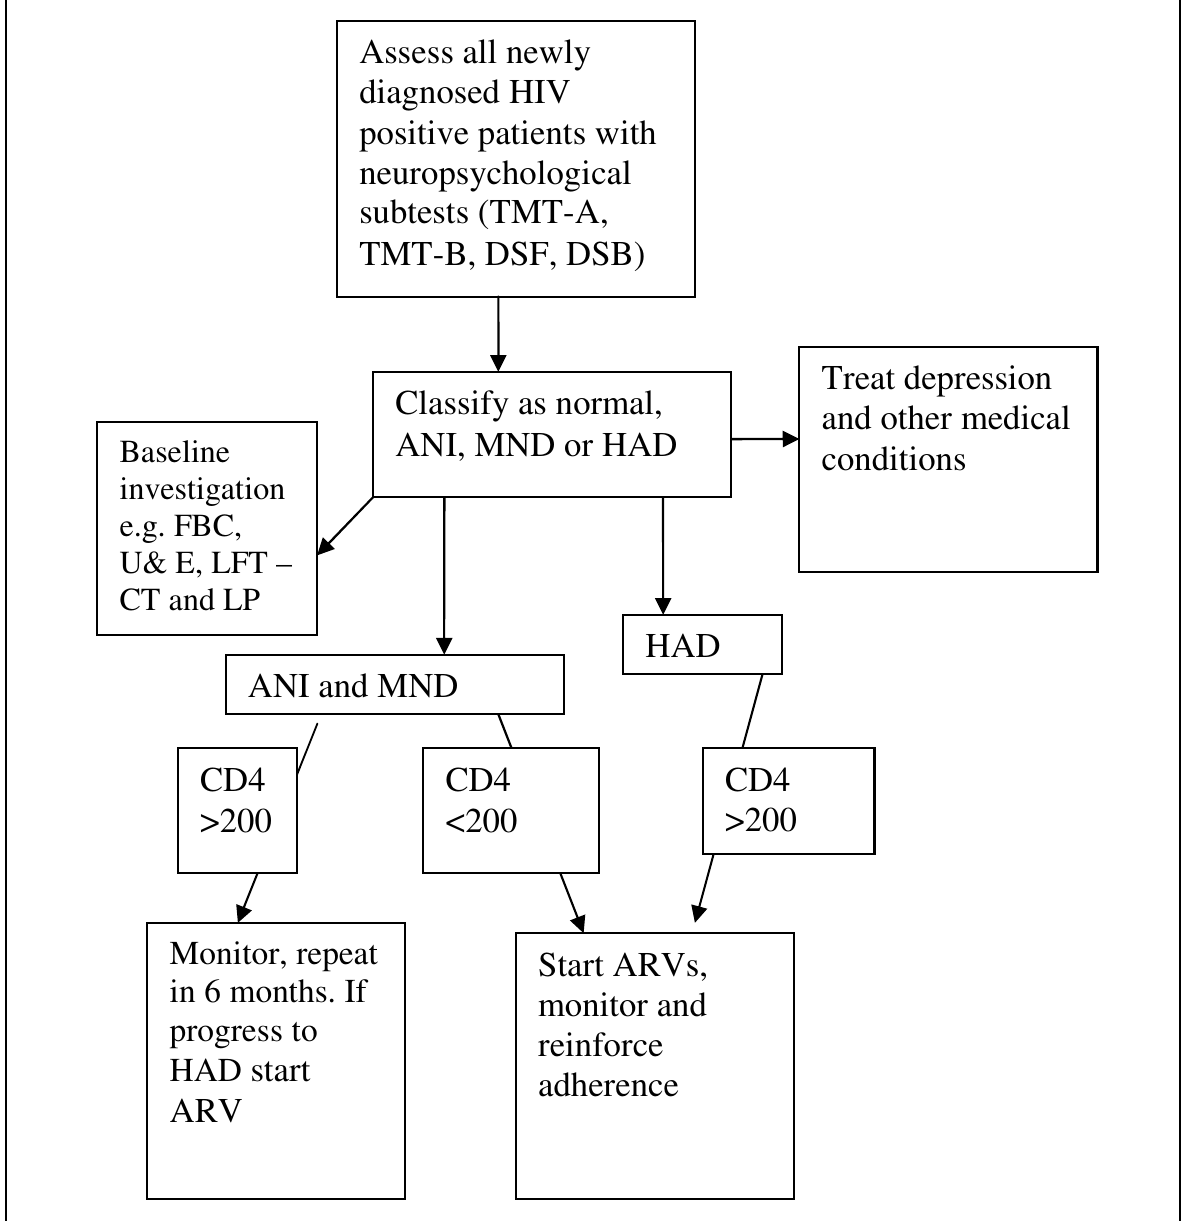
Fig. 1. Summary assessment and management of neurocognitive function in newly diagnosed PLWHA.